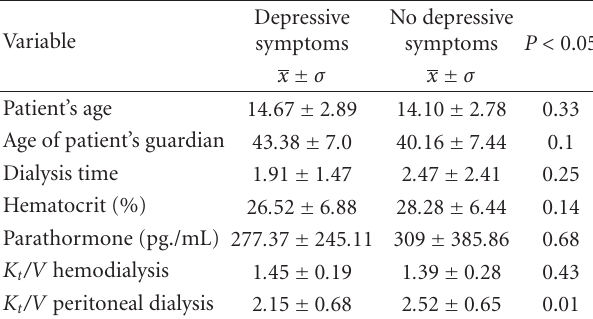
Table 2: Correlation of depressive symptoms (score above 13 ac- cording to Birleson Scale) and no depressive symptoms with clinical and demographic variables.